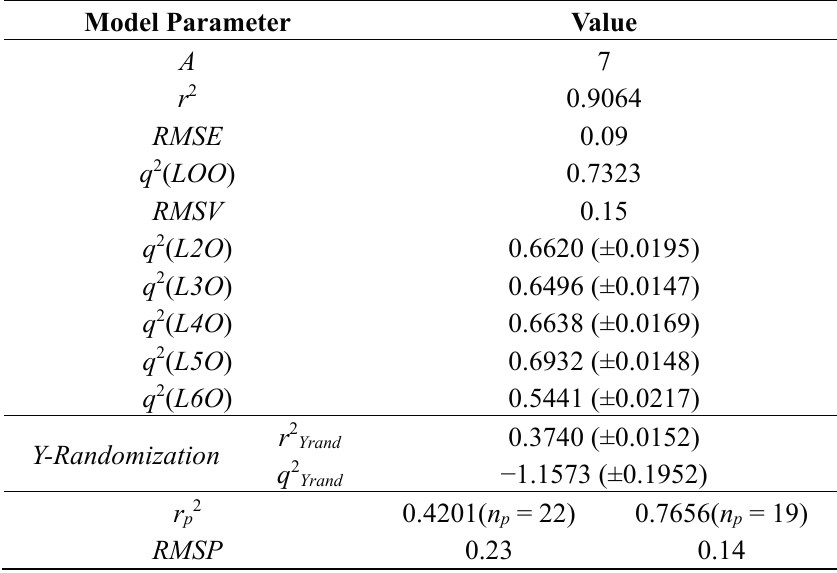
Table 4. The statistical parameters and their values in PLS regression